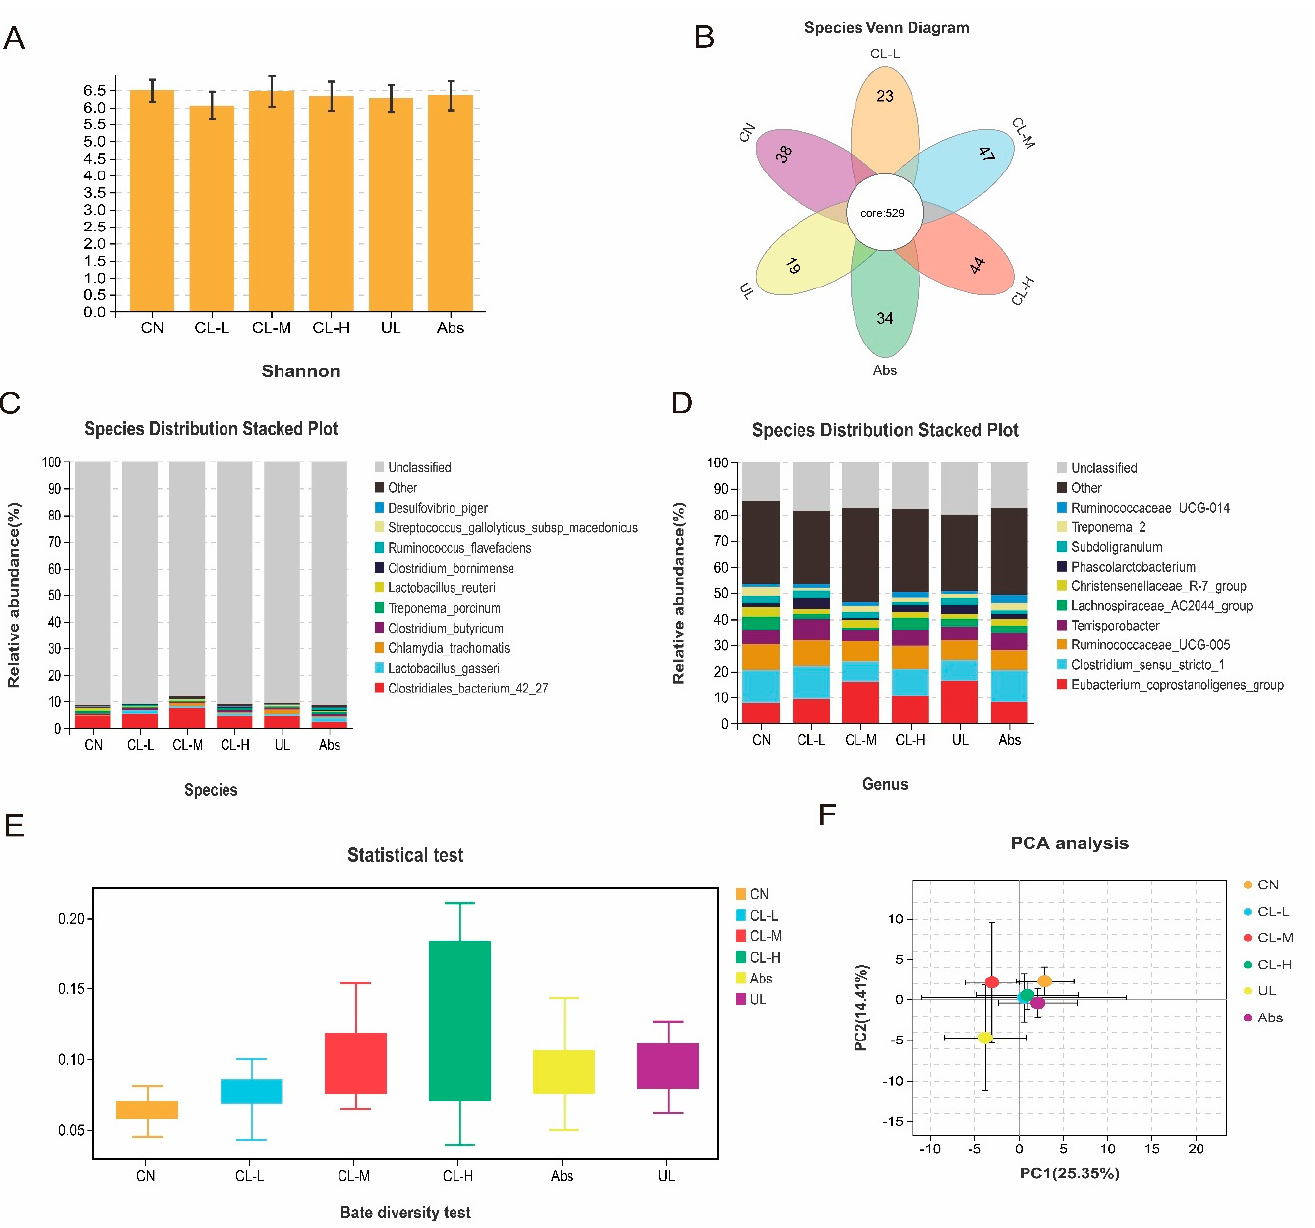
Figure 5. Summary of the microbial community in the cecal contents of piglets. ( A ) Shannon index in the alpha diversity analysis. ( B ) Venn diagram of OTUs. ( C ) Species-level species distribution stacked plot. ( D ) Genus-level species distribution stacked plot. ( E ) Statistical tests for beta diversity analysis. ( F ) PCA.